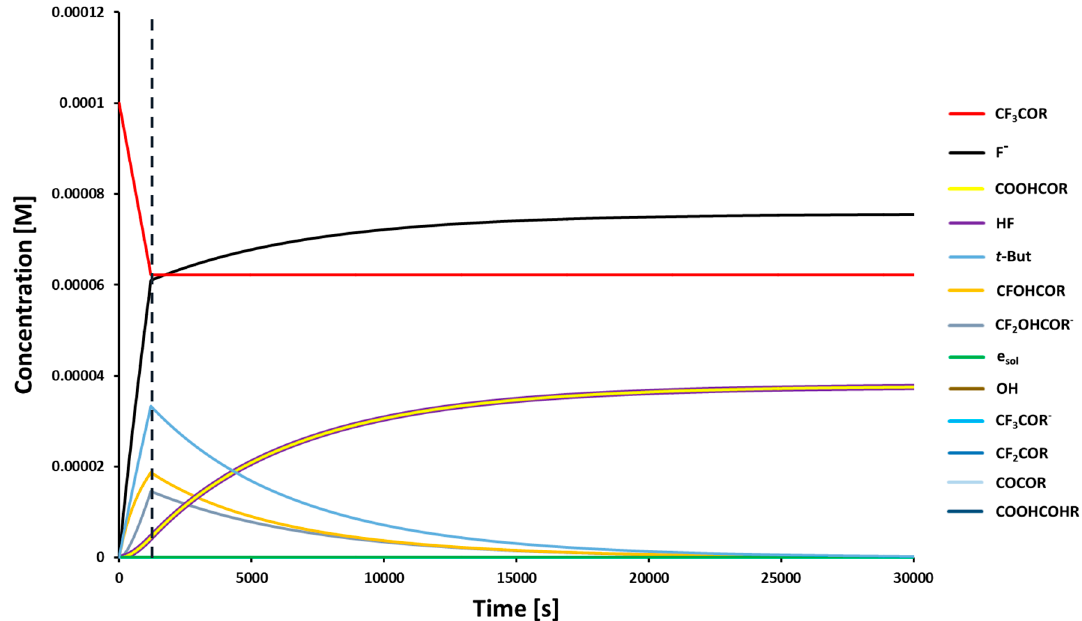
Figure 7. Kinetic curves for particular species involved in the radiolysis of a CF 3 CONHU solution (R = NHU). The vertical broken line indicates the moment at which the X-ray source was turned off. The system of kinetic equations (Equation S1) has been integrated for 3 × 10 4 s.